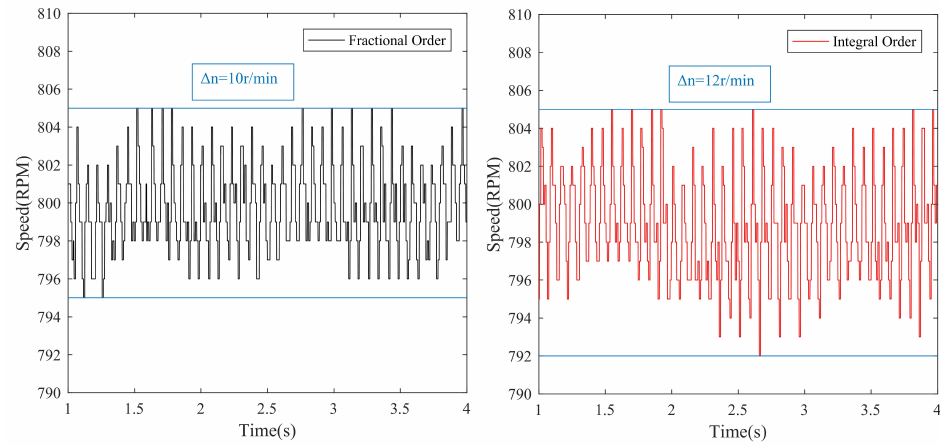
Figure 12. The speed fluctuation of motor at high speed.